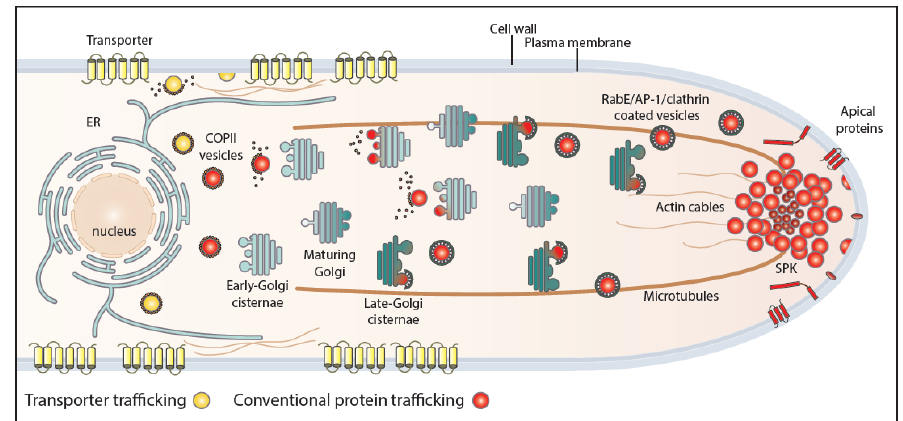
Figure 2. Conventional and transporter-related trafficking routes. Schematic depiction of the distinct tra ffi cking routes of transporters and apical membrane proteins in A. nidulans. Apical cargoes are polarly secretedtotheplasmamembrane(PM)throughtheconventionalpathway. Briefly,theyexitthe endoplasmic reticulum (ER) in COPII vesicles, which fuse with early Golgi cisternae after uncoating and pass via Golgi maturation to late-Golgi cisternae. From there, apical cargoes get packed in AP-1 / clathrin-coated vesicles with the recruitment of the small GTPase RabE and move along microtubules towards the Spitzenkörper (SPK). The final step of this pathway involves fusion to the PM via the exocyst complex. Transporters are sorted to the PM via a distinct non-polar pathway that bypasses the Golgi and does not necessitate Rab GTPases, AP adaptors, or microtubules. This route requires functional COPII vesicles, actin network, and the PM t-SNARE SsoA, without excluding the existence of an ER-to-PM intermediate compartment